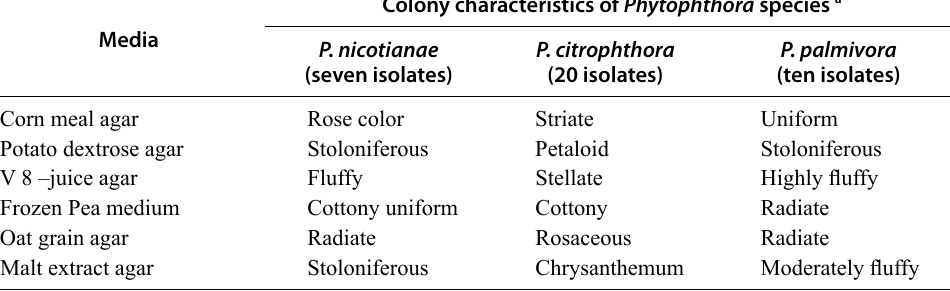
Table 2. Colony patterns of Phytophthora species isolated from Nurseries 1 and 2 on different media. All isolates belonging to the same specie showed the same characteristics.